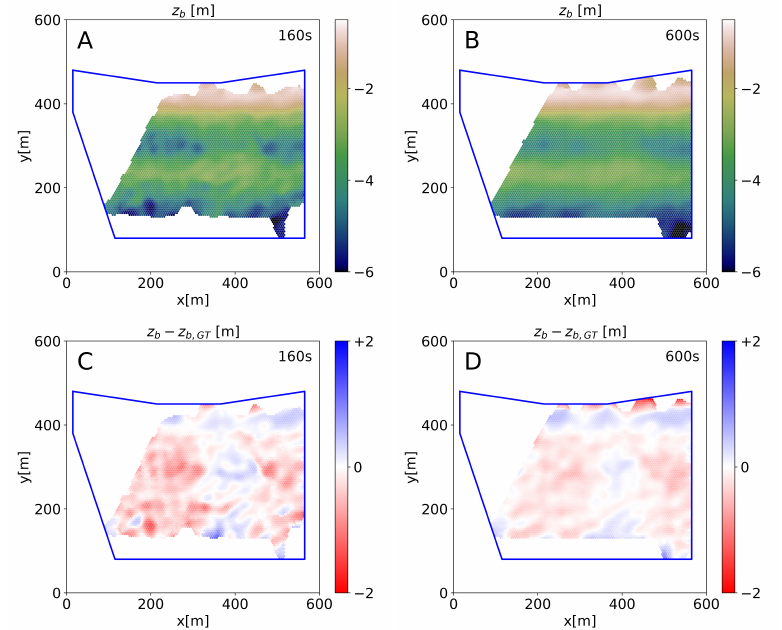
Figure 12. Bathymetry ( top , ( A , B )) and errors ( bottom , ( C , D )), relative to the ground truth ( z b ,GT ) obtained using the 160 s ( left , ( A , C )) and 600 s ( right , ( B , D )) videos.